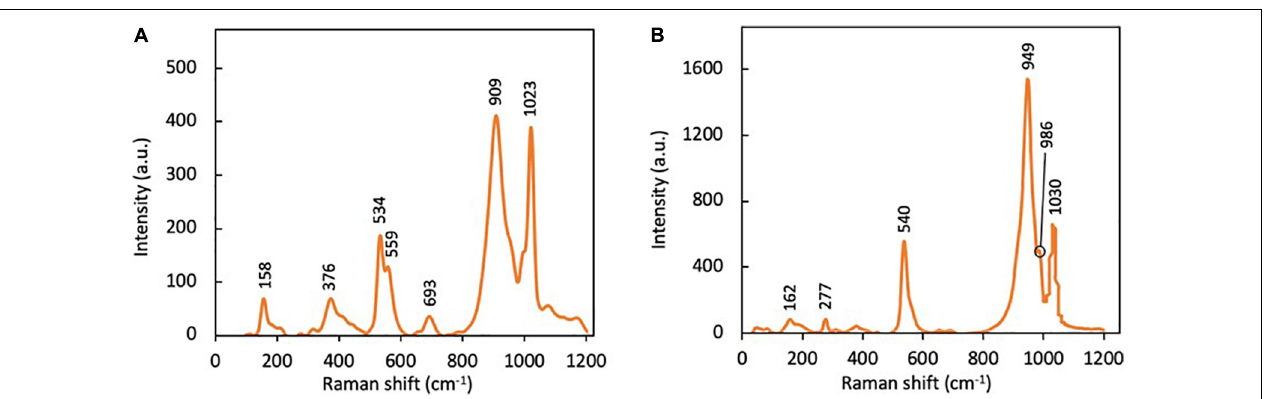
FIGURE 2 | Raman spectra of (A) VOP1 and (B)